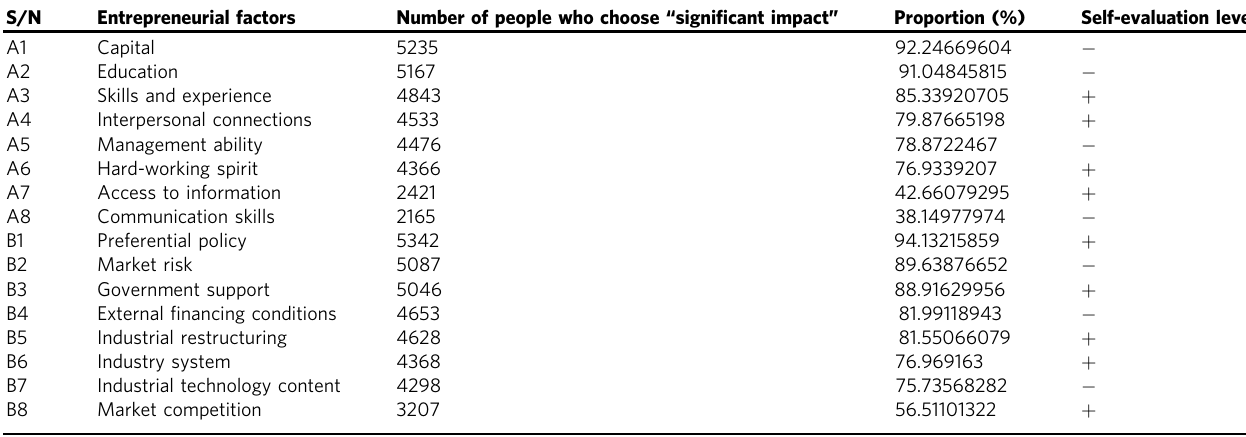
Table 2 Survey and statistics on the importance of factors affecting the entrepreneurial ability of returning migrant workers.